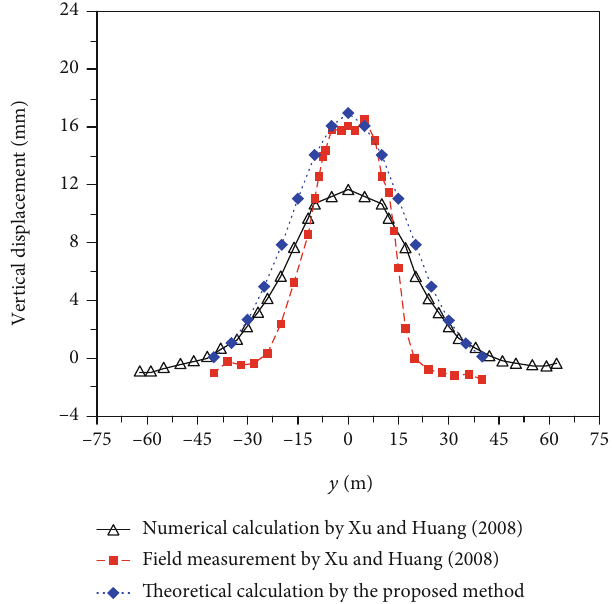
Figure 5: Excavation-induced tunnel vertical displacements for the SDRI